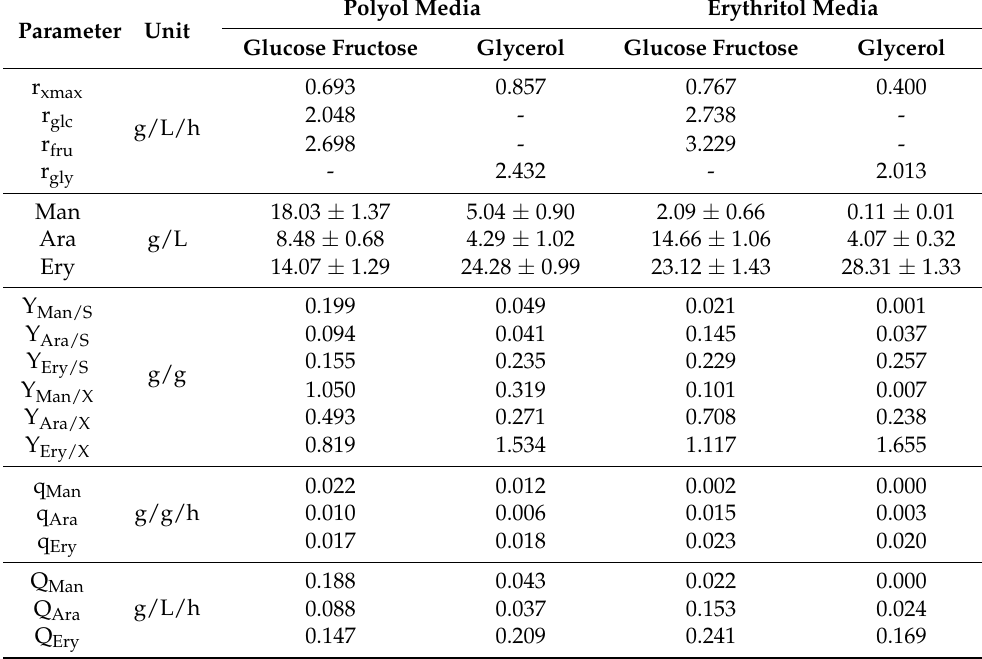
Table 2. Parameters of bioreactor cultures for polyol biosynthesis using Y. lipolytica SpH1-Y1-Y3-Y4 in media containing a mixture of glucose and fructose or glycerol. The cultivations were carried out until complete depletion of the substrate(s) and were performed in three biological